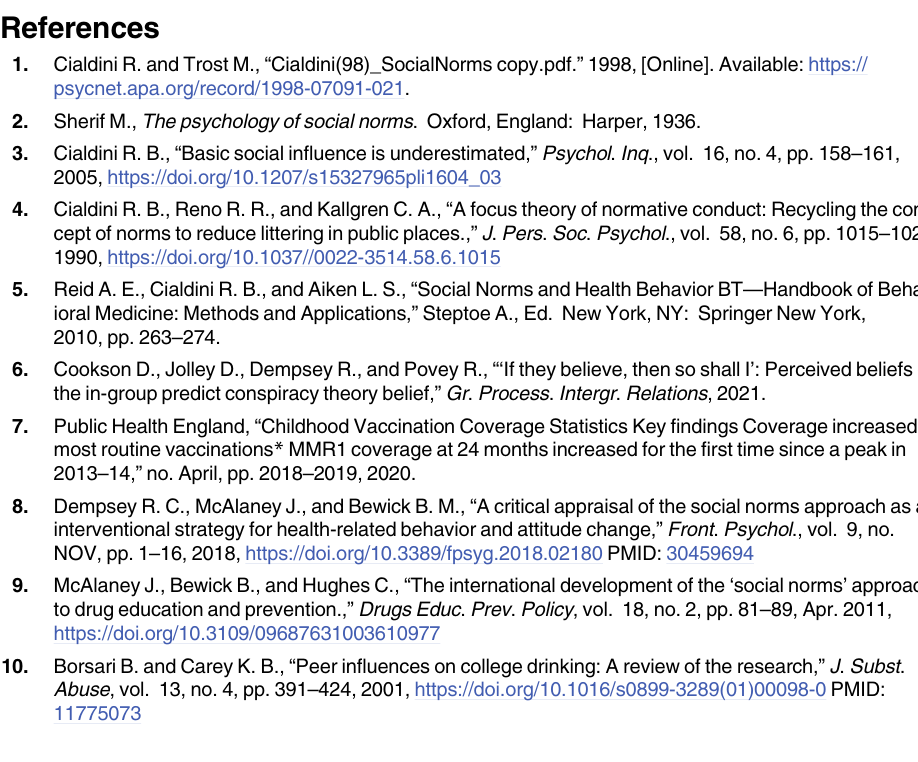
S1 Table. Analyses of variance of the effect of the intervention on personal beliefs in anti- vaccine conspiracy theories. S2 Table. Analyses of variance of the effect of the intervention on personal vaccination